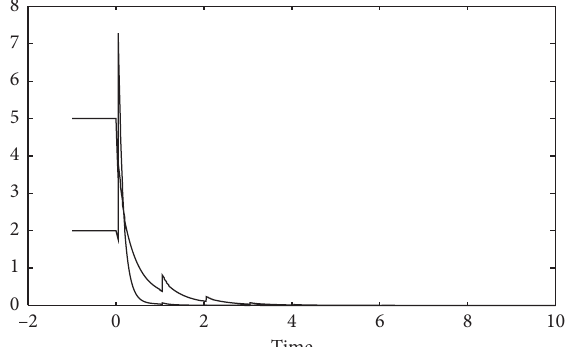
Figure 2: The state response of the neural networks in Theorem 1.